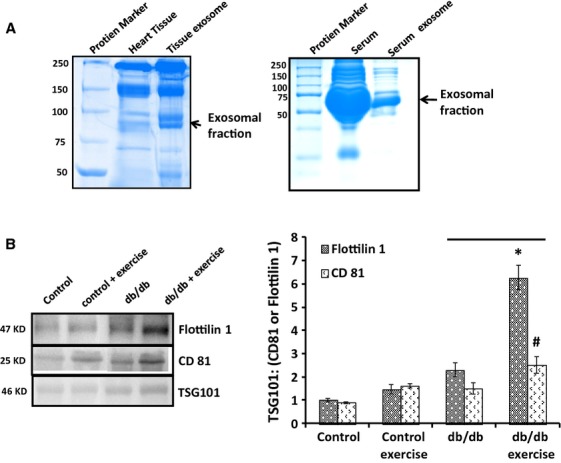
Confirmation of exosomal markers CD81 and flottilin 1. The exosomal fraction from both heart and serum was separated on SDS PAGE (A) and transferred to hybond N+ for Western blotting. The first lane shows the exosomes from the serum of db/db control mice (Jackson Laboratory) without exercise while the second lane shows the same with exercise. (B) The exosomal fractions showed higher expression of CD81 and flottilin 1 proteins in the exercise group as compared to the non-exercise group.